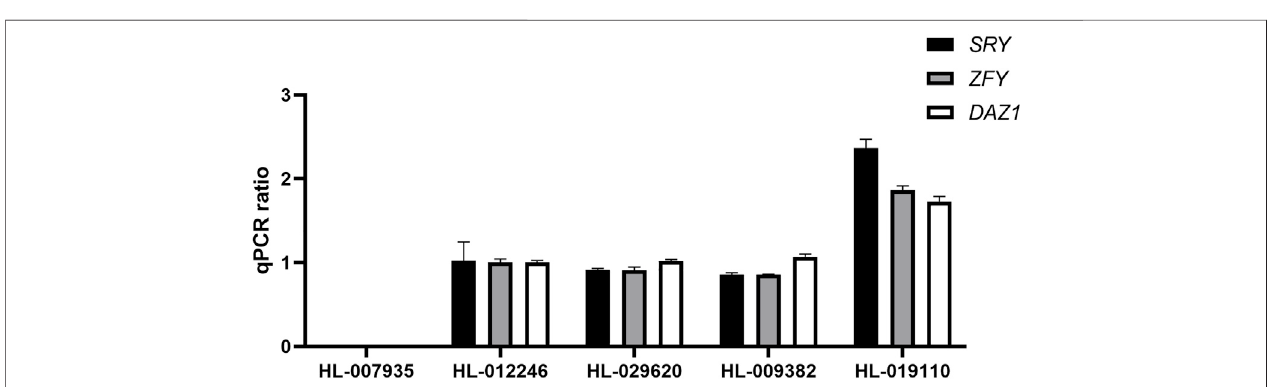
FIGURE 5 | Quantitative determination of Y chromosome copy